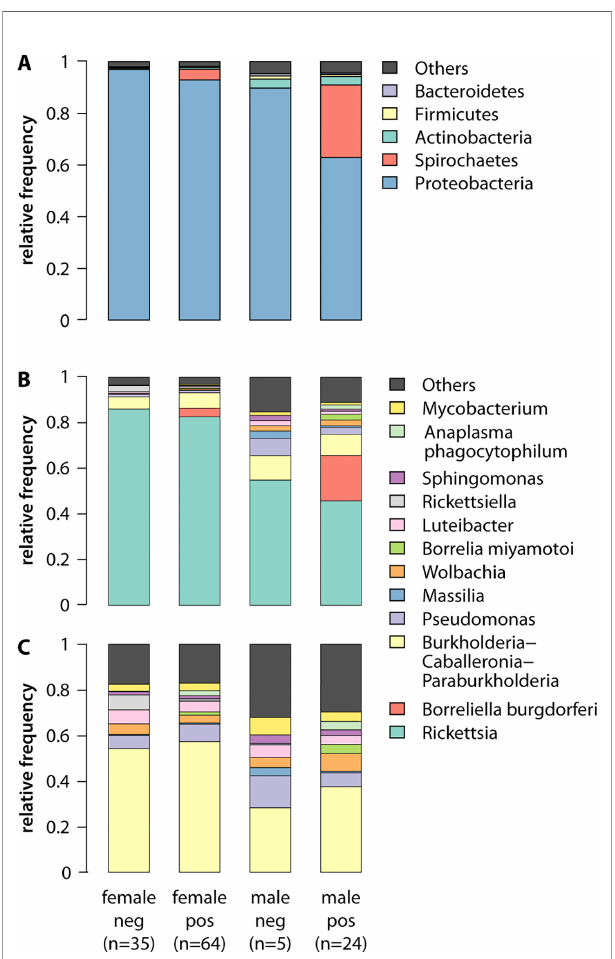
FIGURE 4 | Overall beta diversity of the microbiome does not differ by B. burgdorferi infection status; however, speci fi c taxa are signi fi cantly over and underrepresented in infected ticks. (A) Beta diversity, measured by weighted Unifrac distance, differed signi fi cantly between infected (blue) and uninfected (red) ticks (pseudo-F test = 8.28366, p = 0.001), but (B) this difference disappears once B. burgdorferi is removed from the analysis (pseudo-F test = 1.53959, p = 0.206). (C) LEfSe discriminant analysis shows that reads from B. burgdorferi and Cutibacterium are signi fi cantly more abundant (orange) in B. burgdorferi- positive ticks, while reads from three taxa are signi fi cantly less abundant (purple), including Rickettsia . (D) The underabundance of Rickettsia persists in LEfSe analysis of female ticks only, and the number of signi fi cantly more (orange; 5 taxa) and less (purple; 6 taxa) abundant taxa